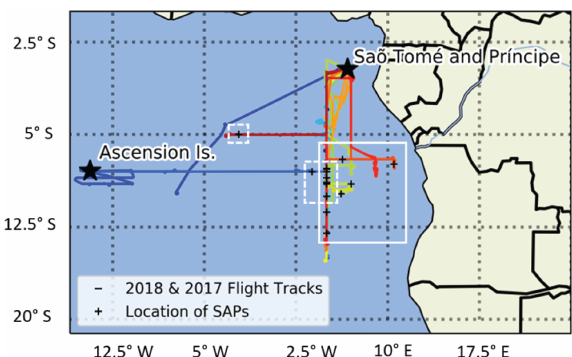
Figure 12. Research fight tracks from the 2017 and 2018 Inten- sive Observation Periods (IOPs) of ORACLES based out of São Tomé and Príncipe over the southeastern Atlantic Ocean (colors show flight tracks on different days). The 2017 and 2018 IOPs were off the coast of Angola. A few flights were conducted westward to Ascension Island for clear air sampling. Locations of observations of SAPs are denoted by the plus signs ( + ). The areas of observed SAPs in 2017 are denoted by the dashed white line and in 2018 by the solid white